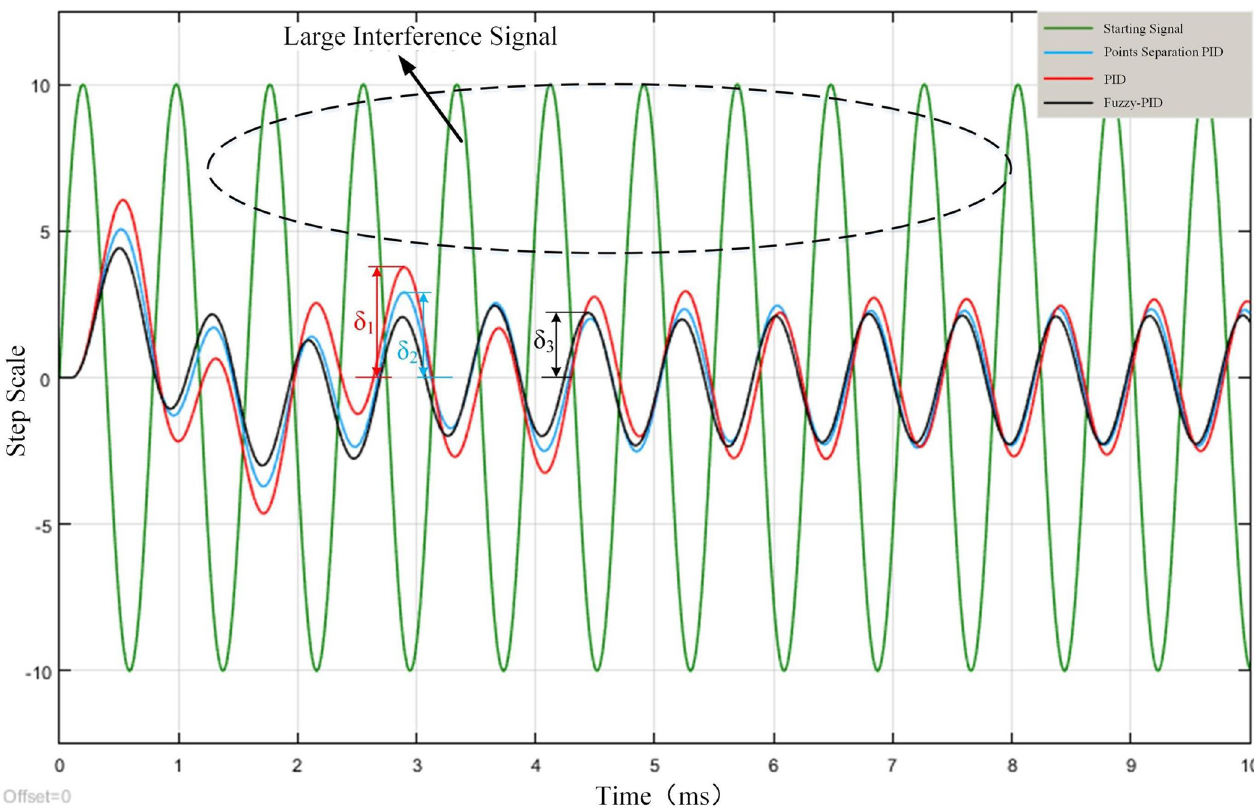
Fig 13. Large interference signal simulation.